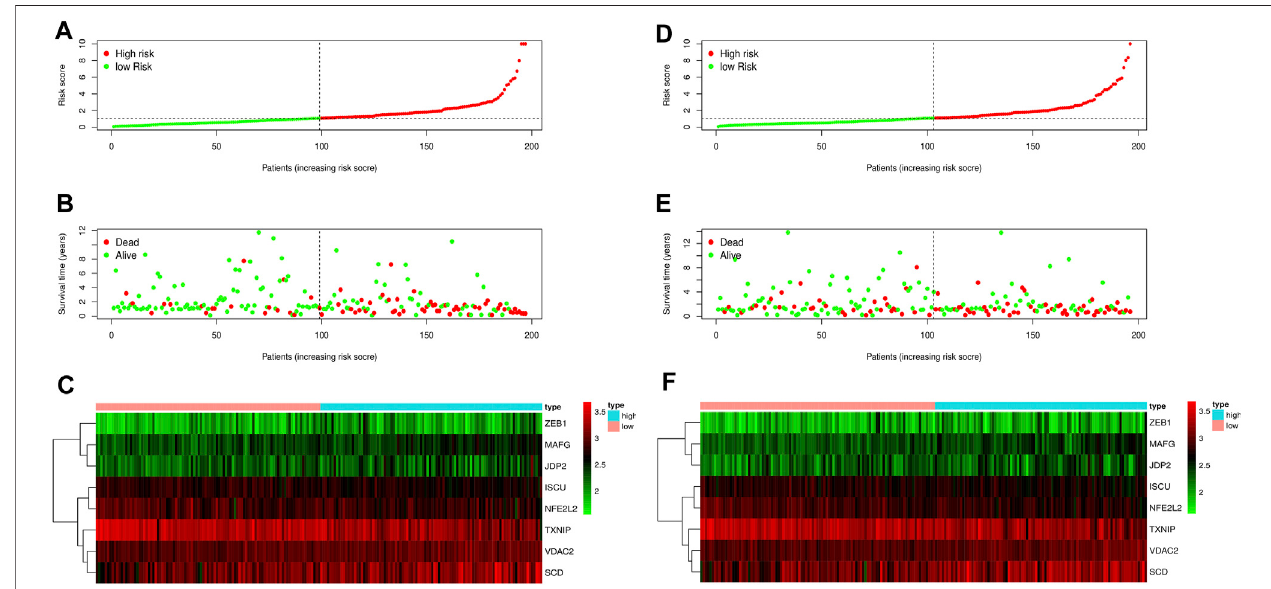
FIGURE 6 | Risk curve of the training set and test set. (A) Risk score distribution of the training set. (B) Survival state distribution of training set. (C) Heat maps of eight ferroptosis-related genes in the training set. (D) Distribution of risk scores in the test set. (E) Survival state distribution of the test set. (F) Heat maps of eight ferroptosis-related genes in the test